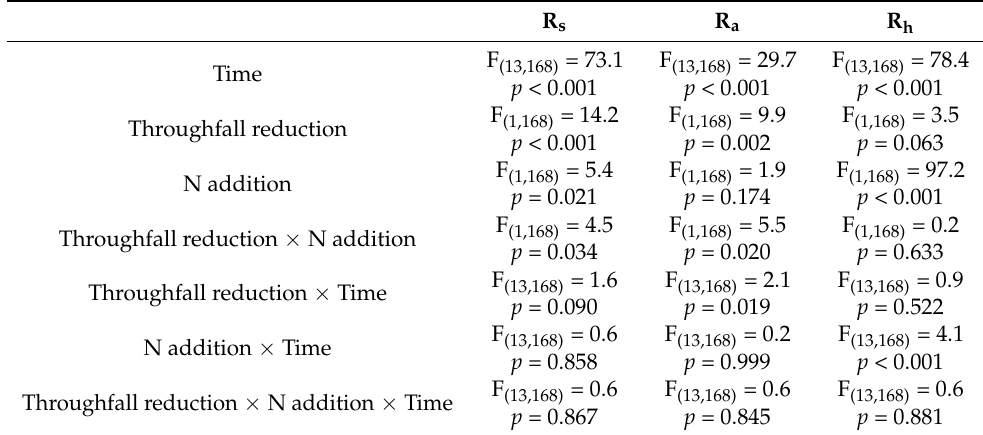
Figure 3. Temporal variation of soil respiration (R s ) (Graph ( a )), soil autotrophic respiration (R a ) (Graph ( c )), soil heterotrophic respiration (R h ) (Graph ( e )), annual cumulative R s (Graph ( b )), annual cumulative R a (Graph ( d )) and annual cumulative R h (Graph ( f )) under ambient (A), throughfall reduction (TR), N addition (N) and throughfall reduction and N addition (TR + N) treatments from September 2017 to August 2018. The error bar represented arithmetic means ± stand errors for four replicates. Table 1. F -values and p -values of three-way ANOVA on the effects of measured time, throughfall reduction, N addition, and their interactions on soil respiration (R s ), soil autotrophic respiration (R a ), and soil heterotrophic respiration (R h